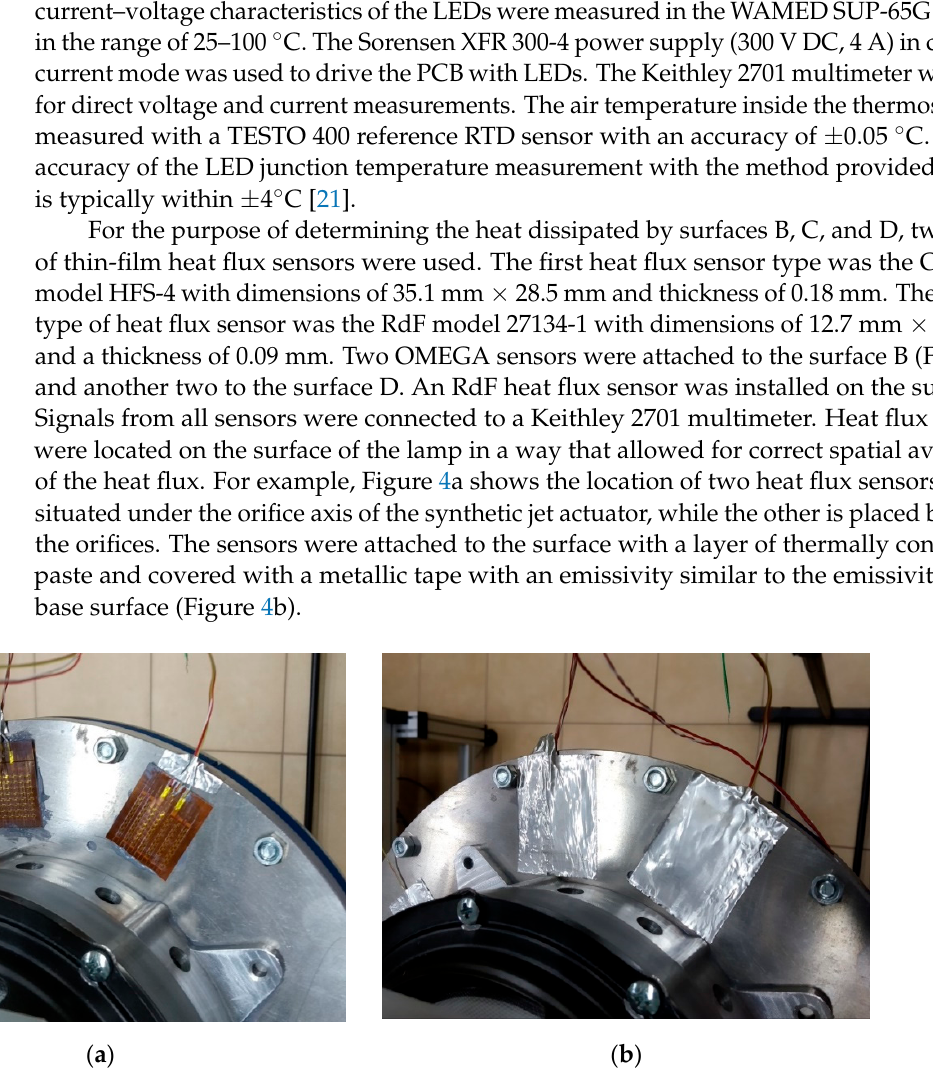
Figure 4. Thin film heat flux sensors attached to surface B, the first sensor was mounted directly below the synthetic jet actuator orifice axis and the second is located between the orifices: ( a ) heat flux sensors attached with a thermal paste; ( b ) heat flux sensors covered with a tape.